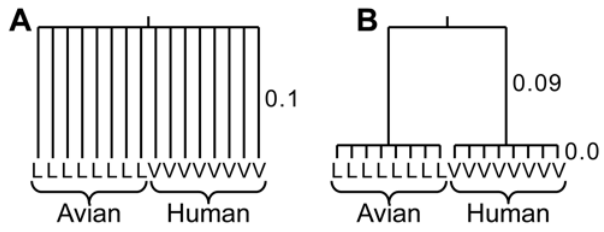
Figure 1. Possible evolutionary scenarios. Two possible phyloge- netic trees representing the situation where eight different avian sequences have a L in a given position, while eight different human sequences have a V. (Branch lengths are not drawn to scale.) The situation shown on the right provides much weaker evidence for a shift in selective constraints compared with the situation shown on the left.